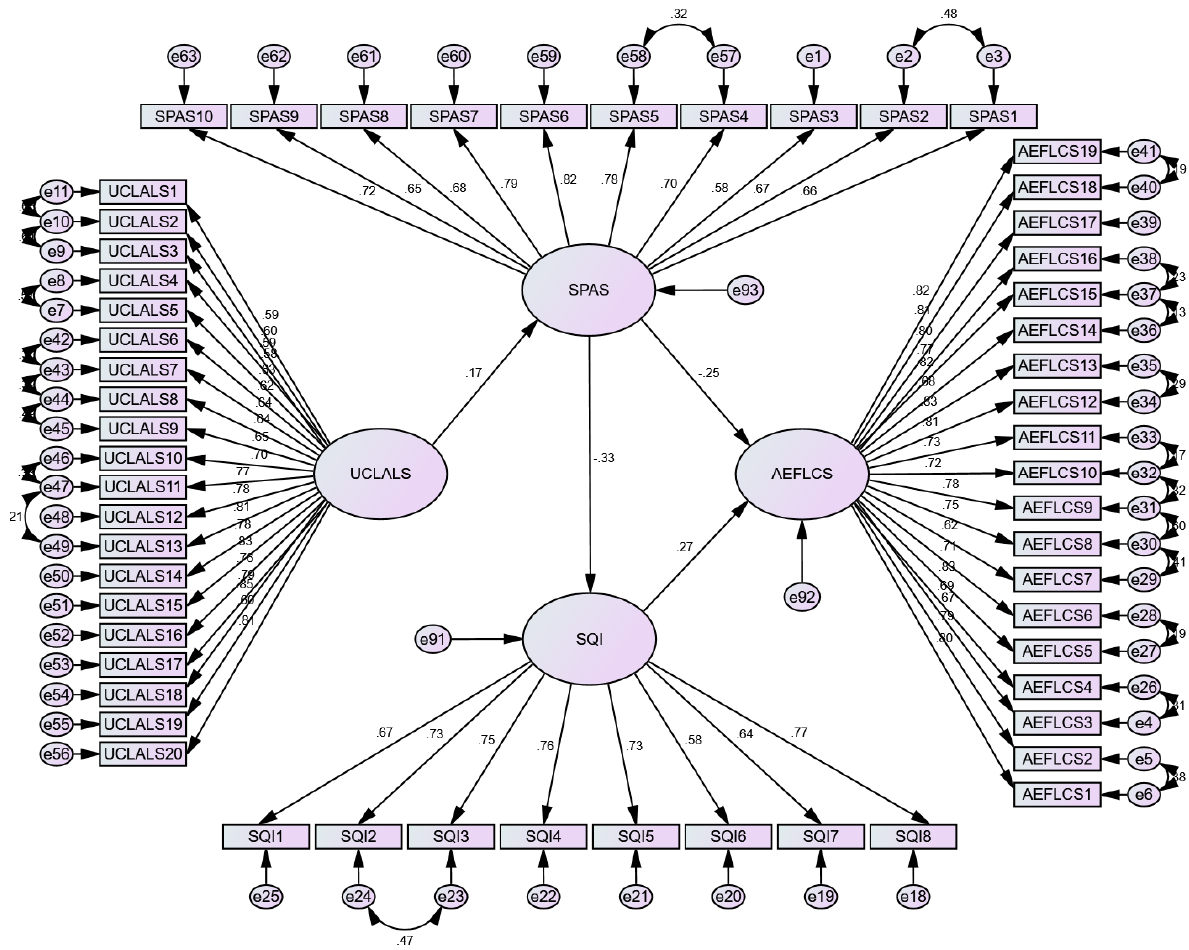
Figure 3. SEM path model. Note: UCLALS = the revised University of California Los Angeles Loneliness Scale; SPAS = the Smartphone Addiction Scale; SQI = Sleep Quality Index; AEFLCS = the Attention in EFL Class Scale.